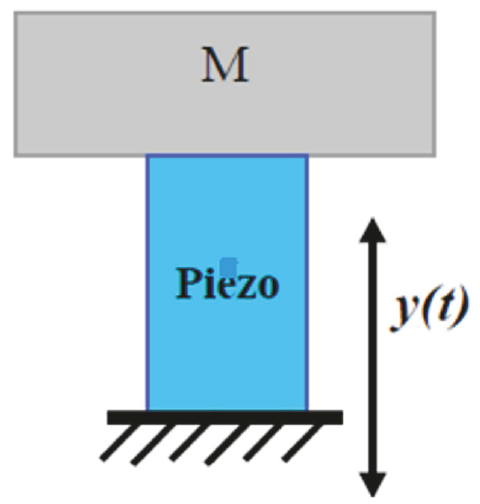
Figure 2: A piezoelectric